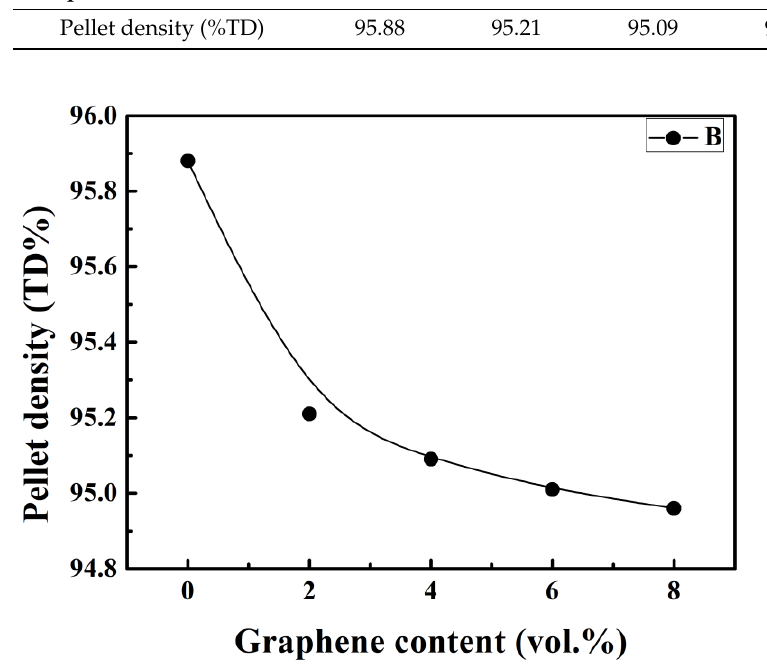
Table 2. Relationship between graphene level and pellet density (%TD).